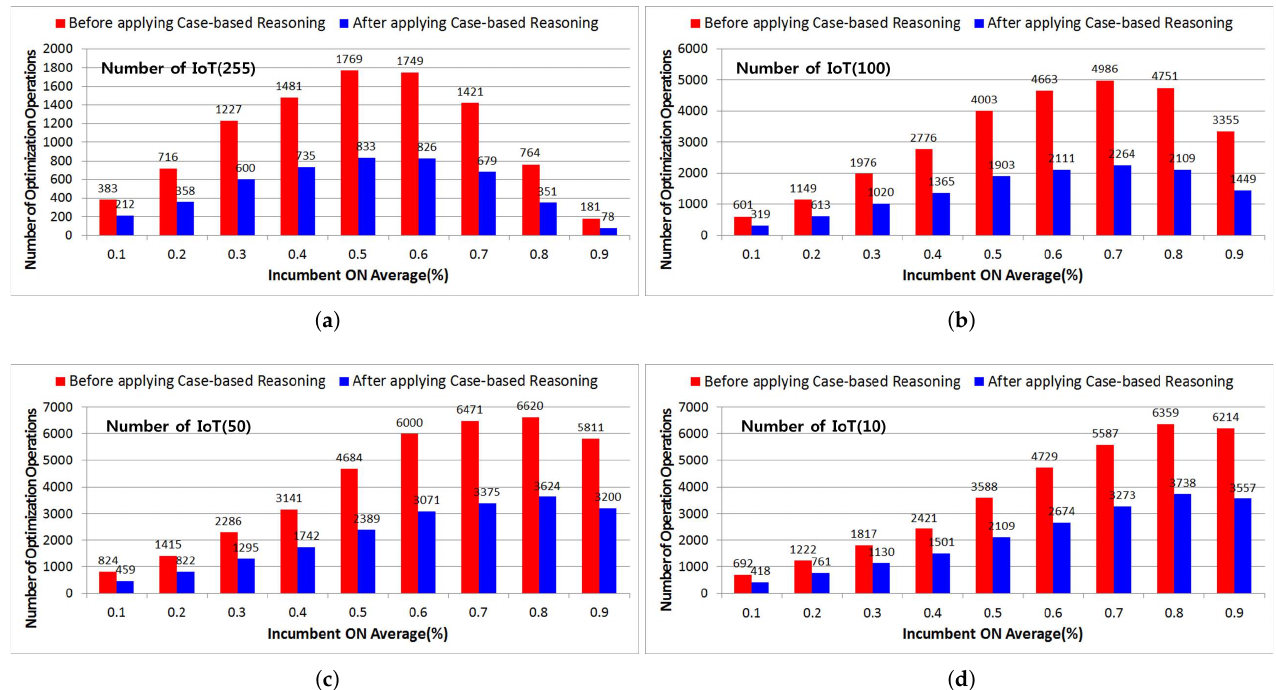
Figure 19. Comparative analysis of the number of optimization engine operations depending on whether or not case-based reasoning is applied. ( a ) Number of IoT: 255, ( b ) Number of IoT: 100, ( c ) Number of IoT: 50, ( d ) Number of IoT: